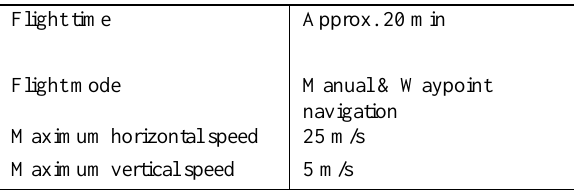
(Figure 11). The lower value of coefficient of determination